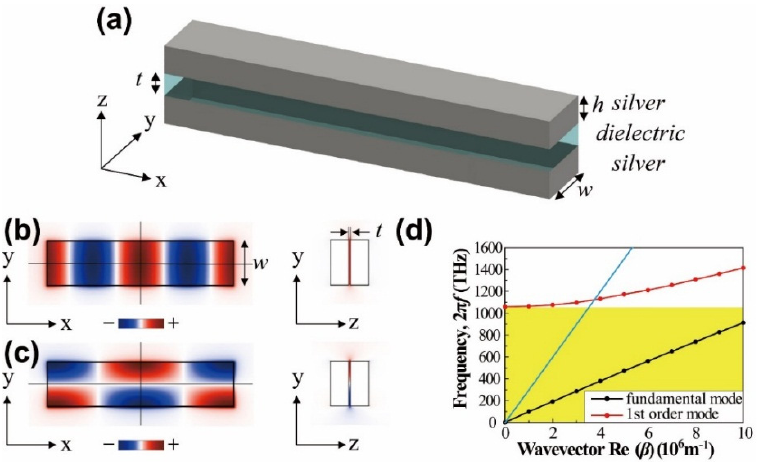
Figure 1. ( a ) Schematic of a metal ‐ insulator ‐ metal (MIM) waveguide consisting of two silver strips and a low ‐ index dielectric layer. The variables w , h , and t represent the waveguide width, the thickness of the silver strip, and the thickness of the dielectric layer, respectively; ( b , c ) Top and side views of the E z electric field profiles of the fundamental and first ‐ order waveguide modes with a wavelength of 1550 nm, w = 240 nm, h = 100 nm, and t = 10 nm. The top view (left) is obtained in the center of the dielectric layer and the side view (right) is obtained along the solid line of the top view; ( d ) Dispersion curves of fundamental (black) and first ‐ order (red) waveguide modes, respectively. The yellow box indicates the mode gap region for the odd waveguide mode. Light line is indicated by blue line.